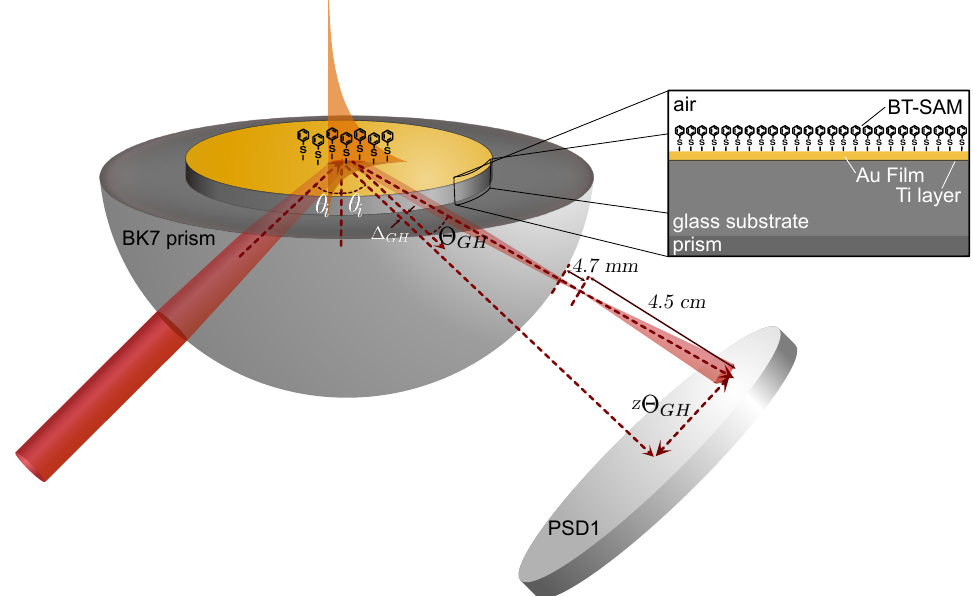
Figure 6. Schematic representation of the experimental setup and the sample geometry and its interaction with the incident